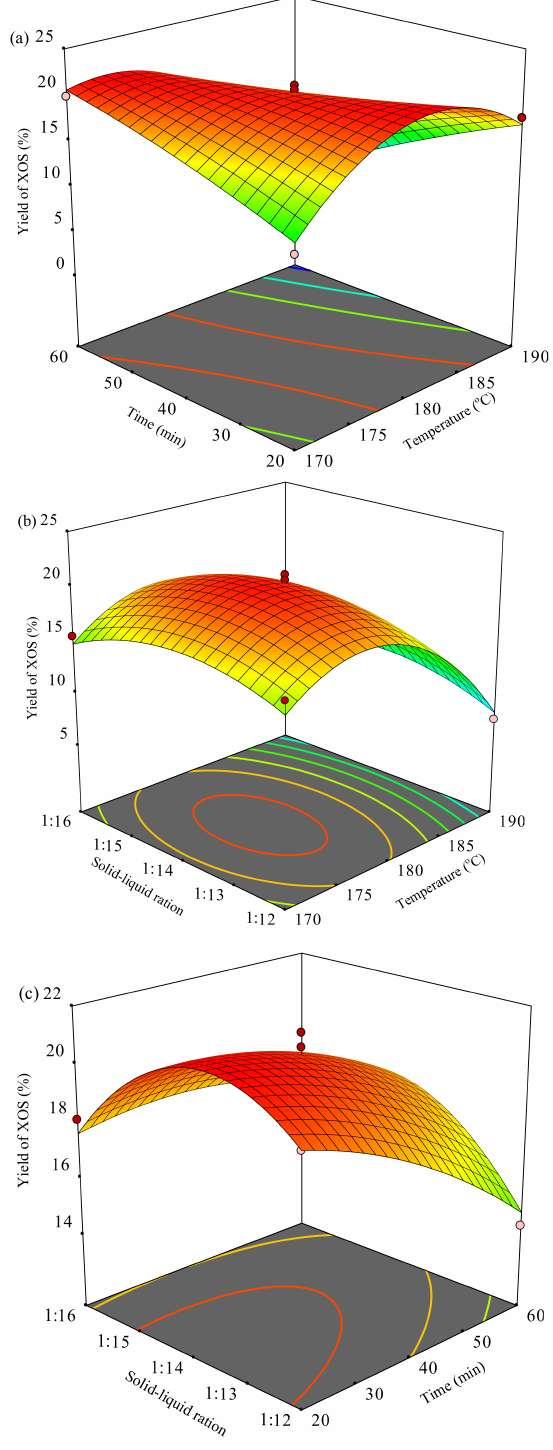
Figure 5. Response surface plot and contour plot for XOS production. ( a ) Effect of interaction of temperature and time on the XOS production when solid-liquid ratio is held at zero level. ( b ) Effect of interaction of temperature and solid-liquid ratio on the XOS production when time is held at zero level. ( c ) Effect of interaction of time and solid-liquid ratio on the XOS production when temperature is held at zero